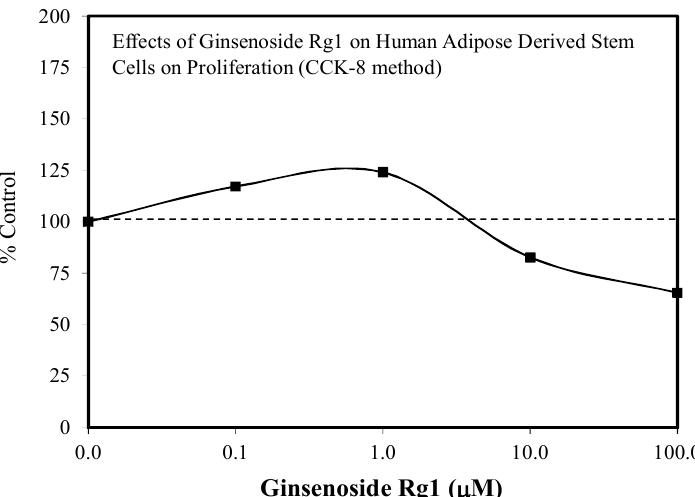
Figure 4. Effects of ginsenoside Rg1 on human adipose-derived stem cells on proliferation (CCK-8 method) (source: [34]).